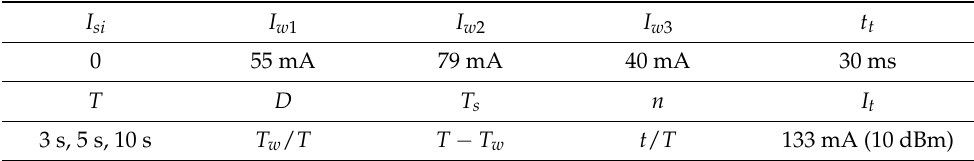
Table 5. Basic parameters of node lifetime